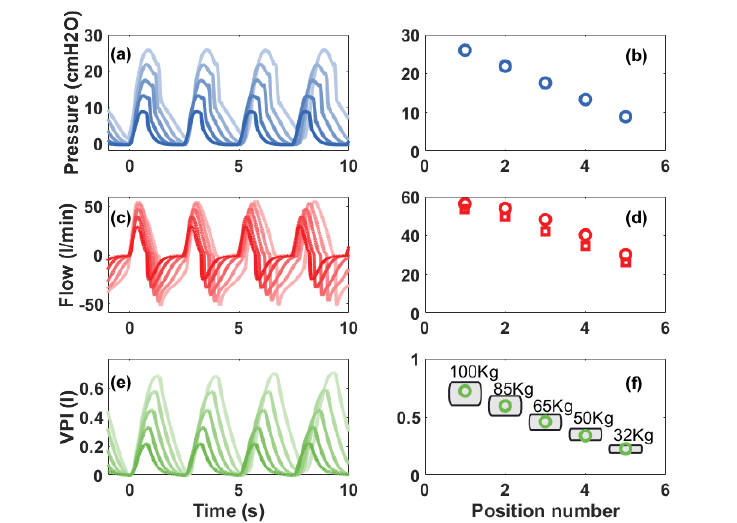
Figure 2. ( a ) Pressure as a function of time for pivot positions 1 (lighter color) to 5 (darker color). ( b ) Peak pressure from plots in ( a ) as a function of pivot position. ( c ) Flow generated as a function of time for pivot positions 1 (lighter color) to 5 (darker color). ( d ) Peak inspiratory (circles) and expiratory flow (squares) as a function of pivot position. ( e ) Volume pumped as a function of time for pivot positions 1 (lighter color) to 5 (darker color). ( f ) Peak volume pumped for the various pivot positions, the gray boxes show the recommended tidal volumes (6 to 8 mL/kg) for various predicted body weights (ideal weights) calculated from the parameters in Table